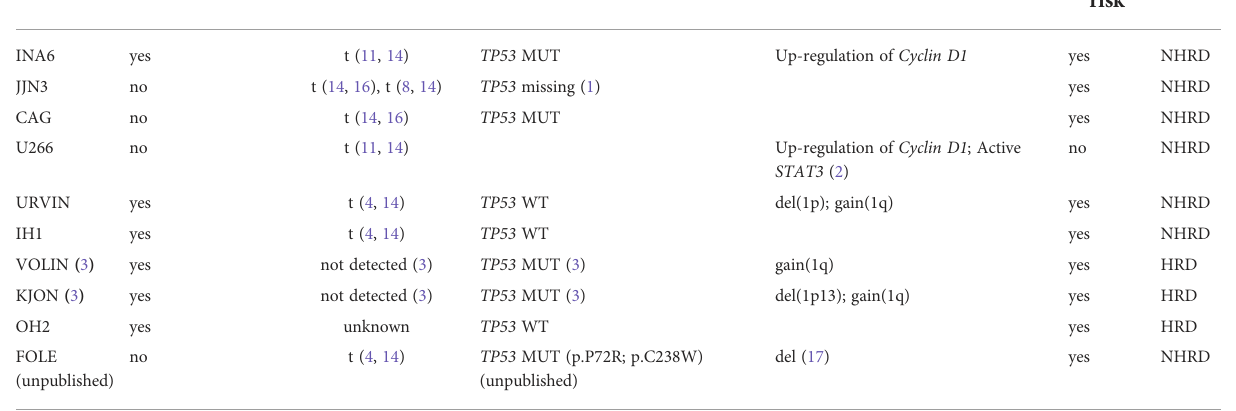
TABLE 1 Characteristics of the MM cell lines included in the